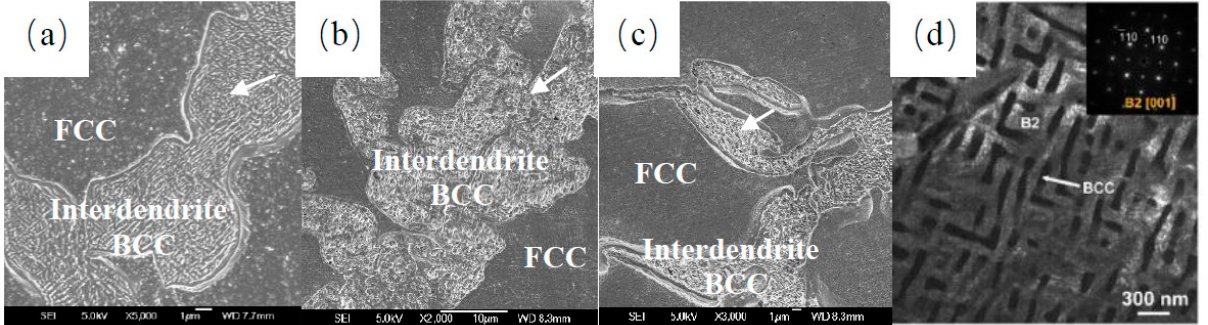
Figure 8. High-magnification SEM images of: ( a ) Co2; ( b ) Ni1.5 and ( c ) Ni2 alloys; and ( d ) TEM of the BCC phase of Al0.6CoCrFeNi alloy [36].